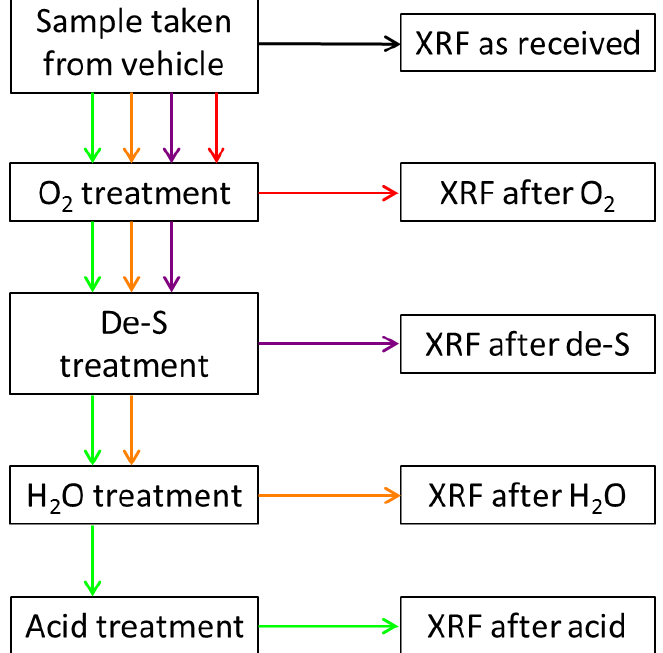
Figure 10. Schematic overview of the treatments undergone by the samples analyzed by XRF to confirm that the contaminant removal procedures had the intended effect.